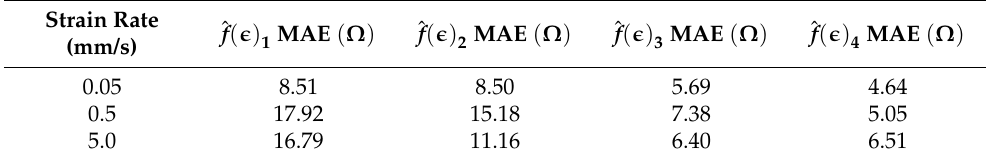
Table 3. The steady-state strain–resistance model, Equation (1), was estimated using the first, second, third, and fourth cycles. The resulting mean-squared error of this model (in Ohms) was used to determine how many cycles were needed for preconditioning purposes.